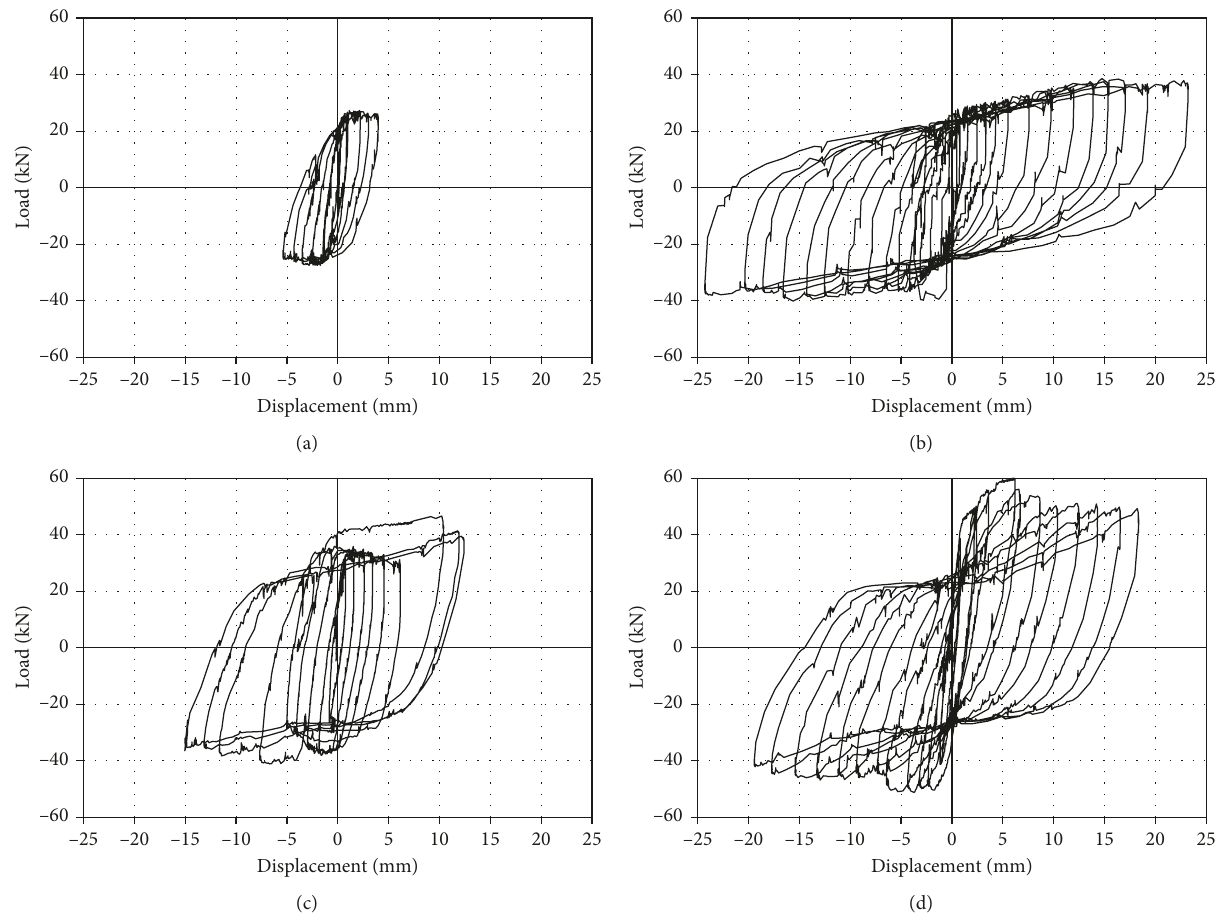
Figure 4: Hysteresis curves of the specimens: (a) specimen #1; (b) specimen #2; (c) specimen #3; (d) specimen #4.